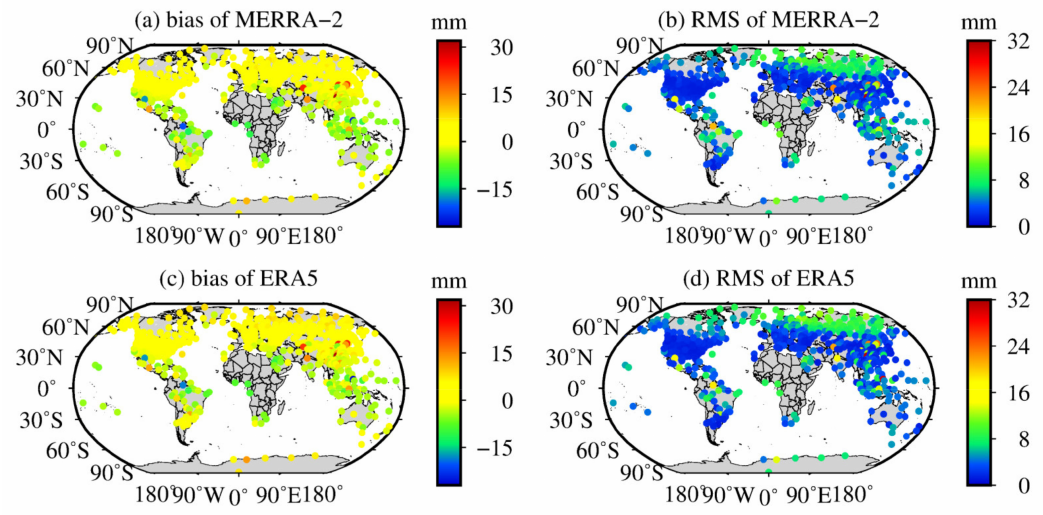
Figure 11. Distributions of the ( a , c ) bias and ( b , d ) RMS of the ZHD values calculated from ERA5 and MERRA-2 pressure- level data with respect to the radiosonde ZHD from 2016 to